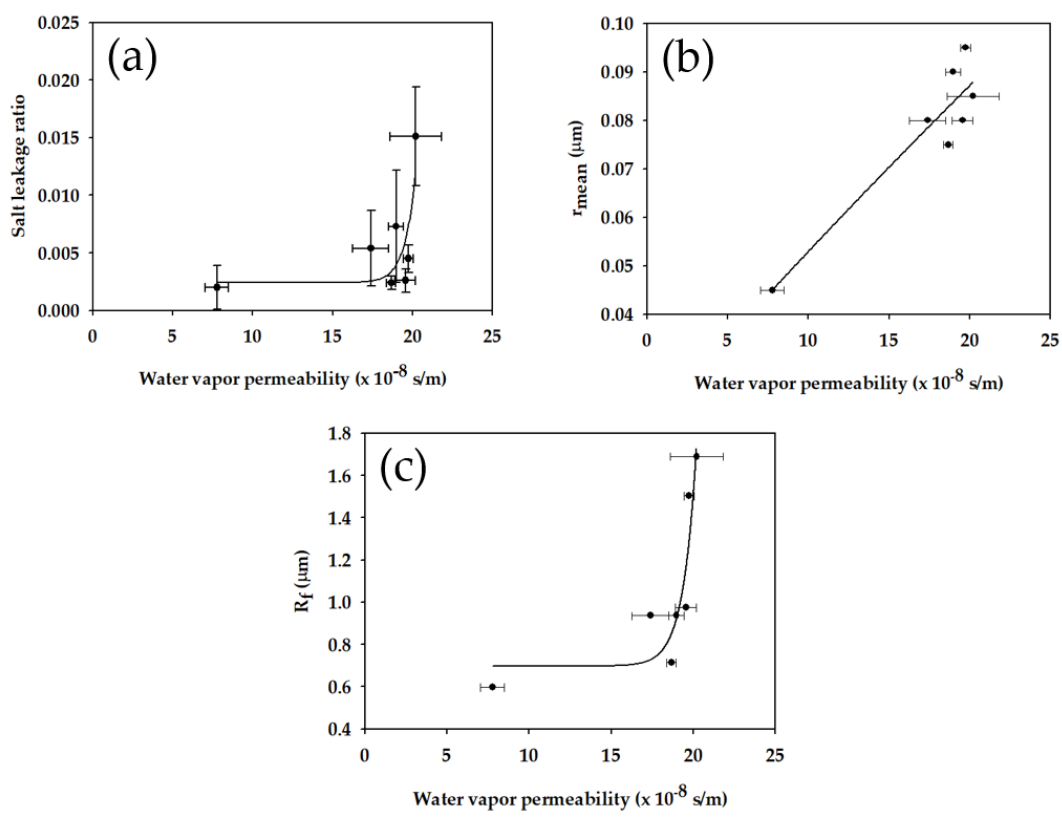
Figure 9. Effect of water vapor permeability ( B w ) on ( a ) salt leakage ratio ( L w ); ( b ) mean pore radius; ( c ) fiber radius ( R f ) of fabricated membranes.